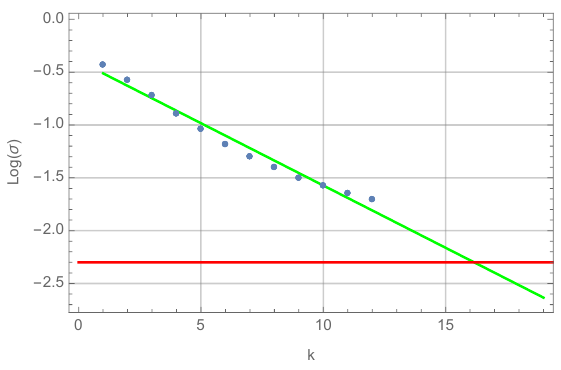
Figure 15 . The value of σ reached by the neural network array on the Fermat quintic would be attained at level k ∼ 16 using Donaldson’s algorithm. The exponential extrapolation was constructed using the data of